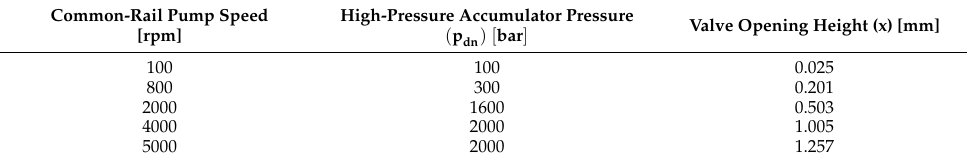
Table 4. Height of the valve opening (x) according to the pump speed and the pressure